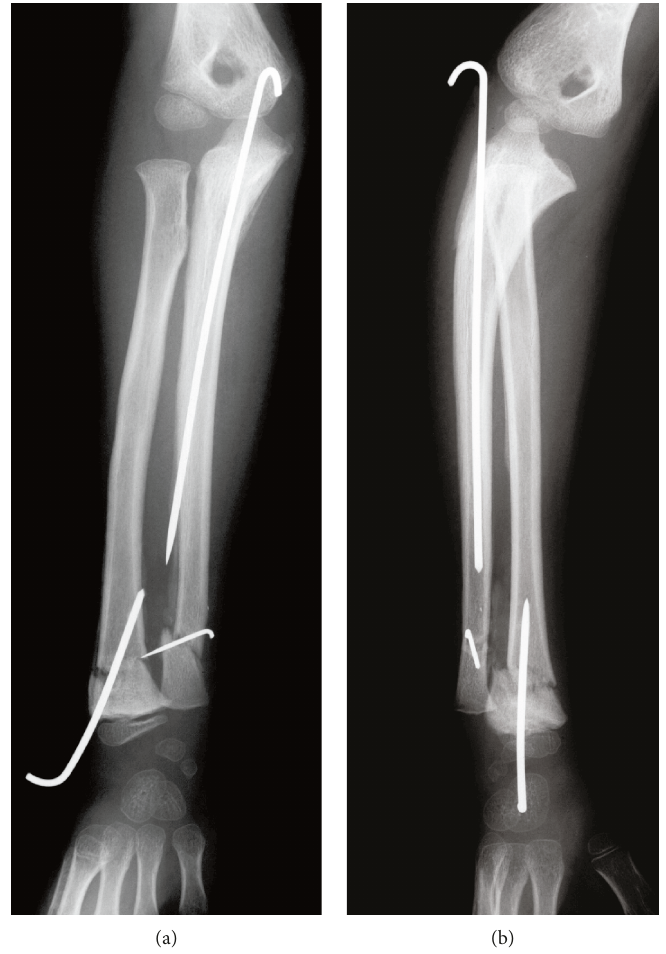
Figure 3: X-rays postoperation. (a) AP view. (b) Lateral view.